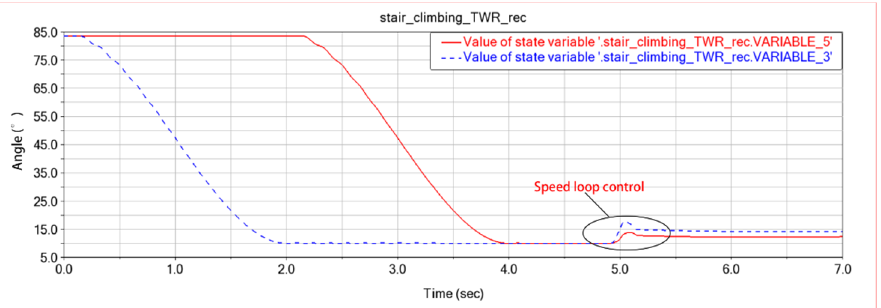
Figure 14. Variation of the vertical inclination angle of the left and right telescopic cantilevers in the gait of “retraction and approaching” climbing stairs.